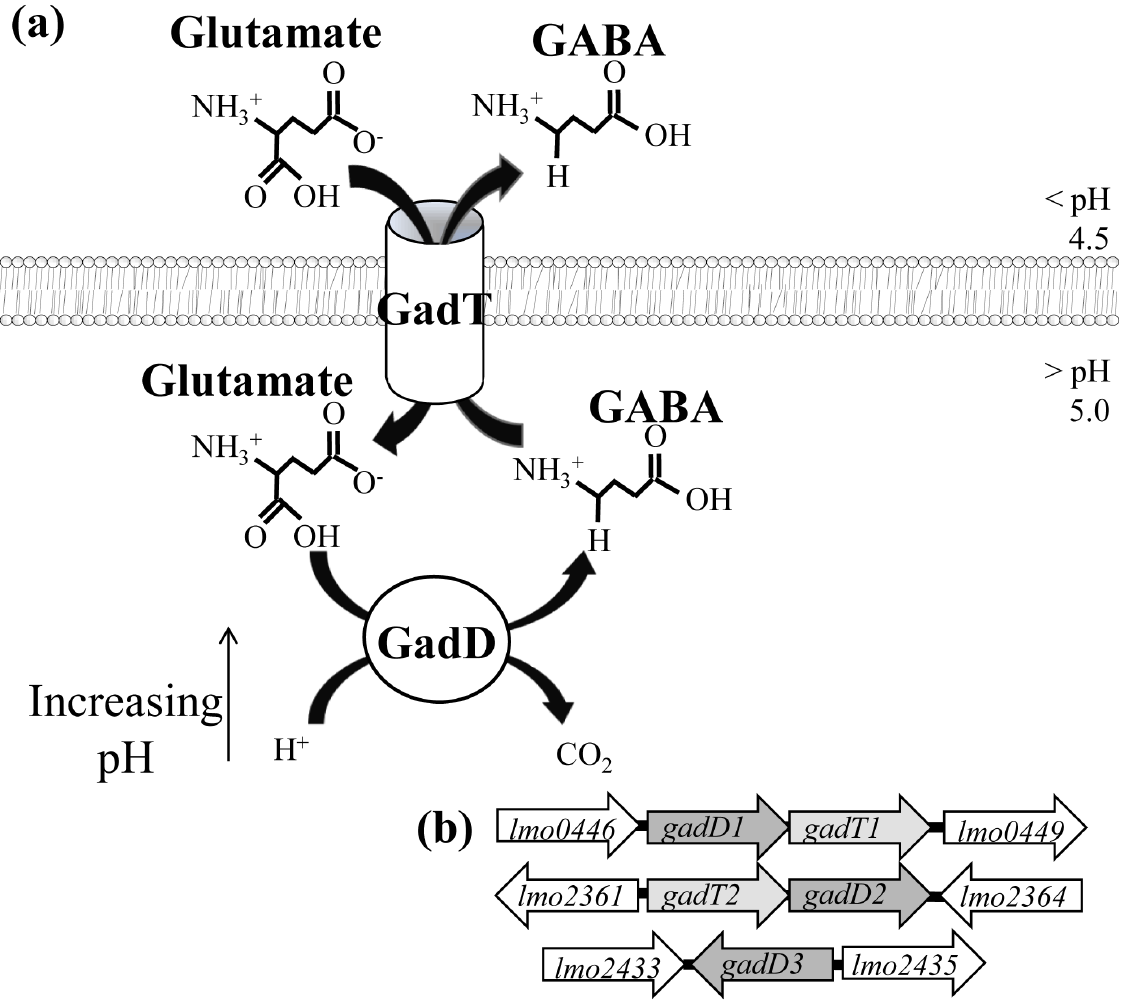
Figure 1. The standard model for the action of the GAD system. ( a ) A membrane bound antiporter carries glutamate into the cell in exchange for GABA. A cytosolic decarboxylase enzyme converts glutamate to GABA, with a consumption of H + . ( b ) The genomic structure of the genes encoding the GAD system in L. monocytogenes EGD-e.